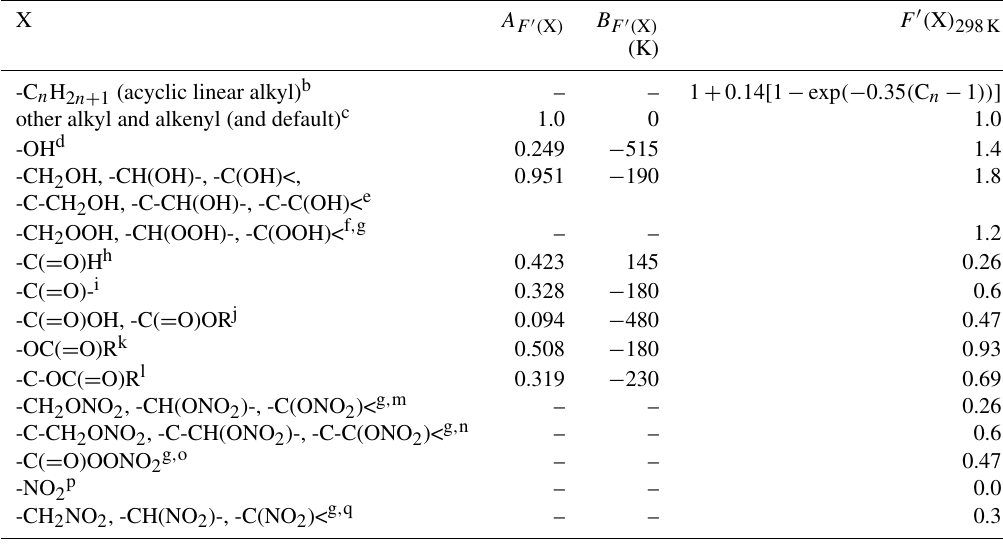
Table 11. Substituent factors, F (cid:48) (X) = A F (cid:48) ( X ) exp ( − B F (cid:48) ( X ) /T ) , for the addition OH to C = C bonds a . X A F (cid:48) ( X ) B F (cid:48) ( X ) F (cid:48) ( X ) 298K (K) -C n H 2 n + 1 (acyclic linear alkyl) b – – other alkyl and alkenyl (and default) c 1.0 0 1.0